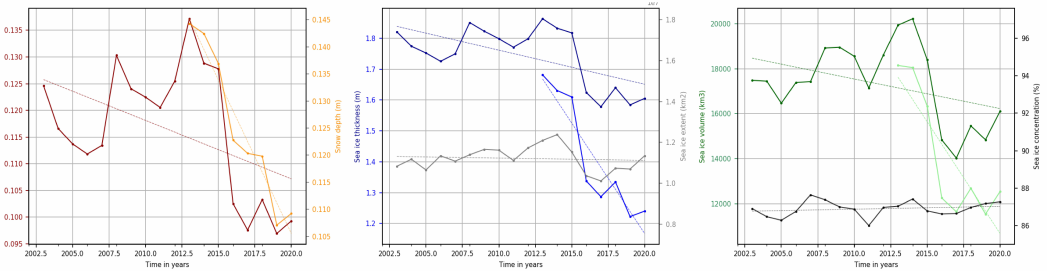
Figure A5. Same as Figure 10 but with only the data of the smallest common area where sea ice concentration is always higher than 50% over